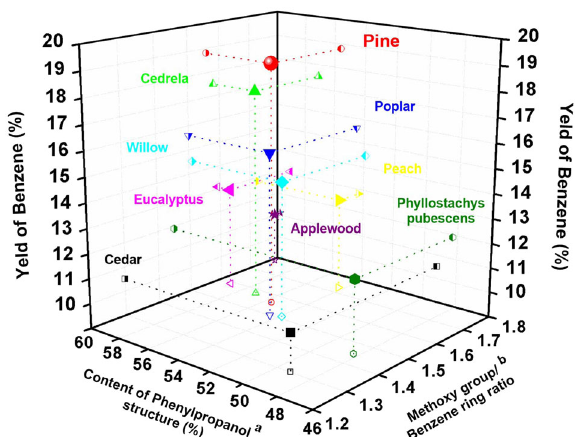
Fig. 5 In situ re fi ning of lignins. 3D plot for the comparison of benzene yield-content of phenylpropanol structure-methoxy group/benzene ring ratio of the employed lignins. Full data are listed in Supplementary Table 9.